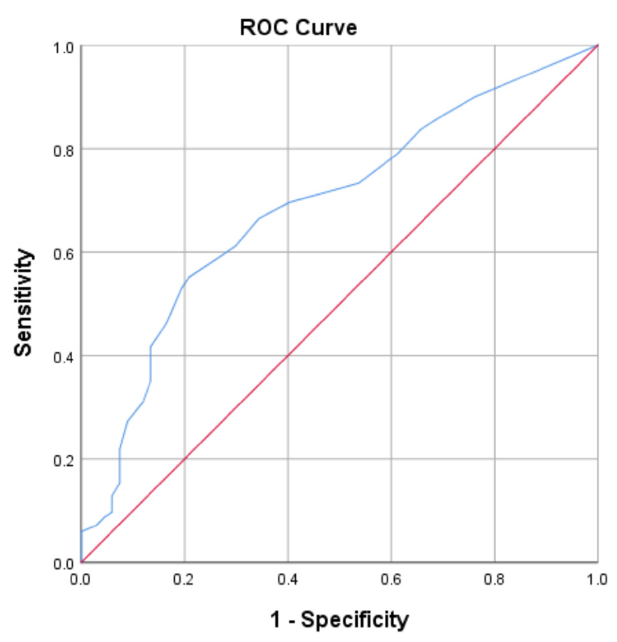
Figure 4. ROC curve for the Screen Dependency Scale. AUC, area under the curve; ROC, receiver operating characteristic. AUC = 0.7. Table 5. Some of the coordinates (scores) of the curve; the sensitivity and specificity of the scores; and the Youden index.